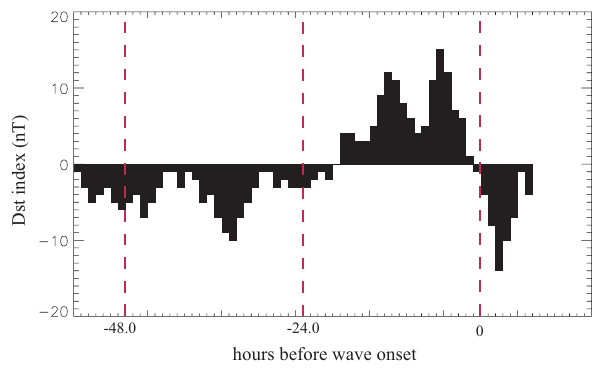
Figure 9. Fig. 9. An analysis of the D st index for ∼ 48h before the wave observed on the 19 February 2001, presented in Fig.